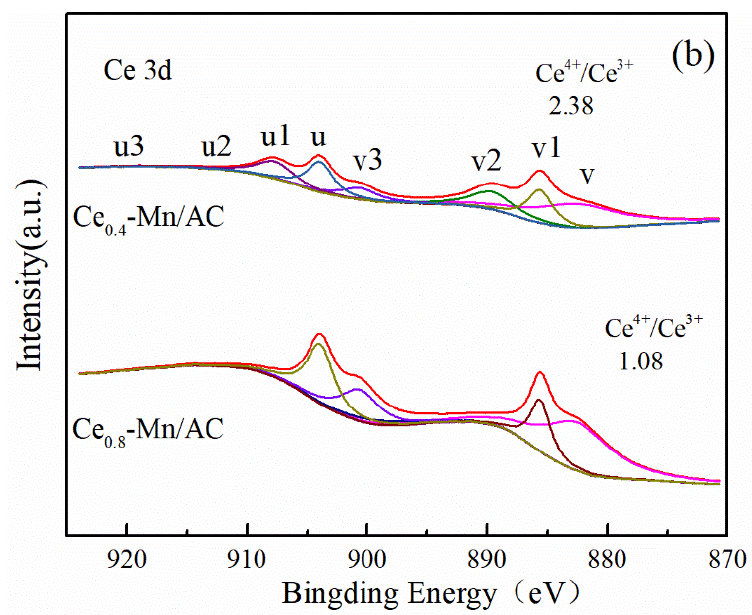
Figure 4. XPS Mn 2p ( a ), Ce 3d ( b ) and O 1s ( c ) spectra on the catalysts. SEM and TEM images of AC carrier, Ce 0.4 -Mn/AC, and Ce 0.8 -Mn/AC are shown